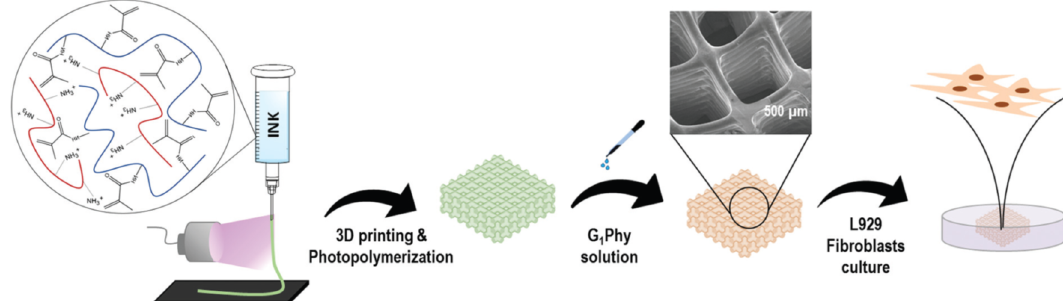
Figure 16. Schematic representation of the printing process applied for obtaining chitosan-methacrylated gelatin 3D polymeric scaffolds. Reproduced from [77]. Published by The Royal Society of Chemistry.